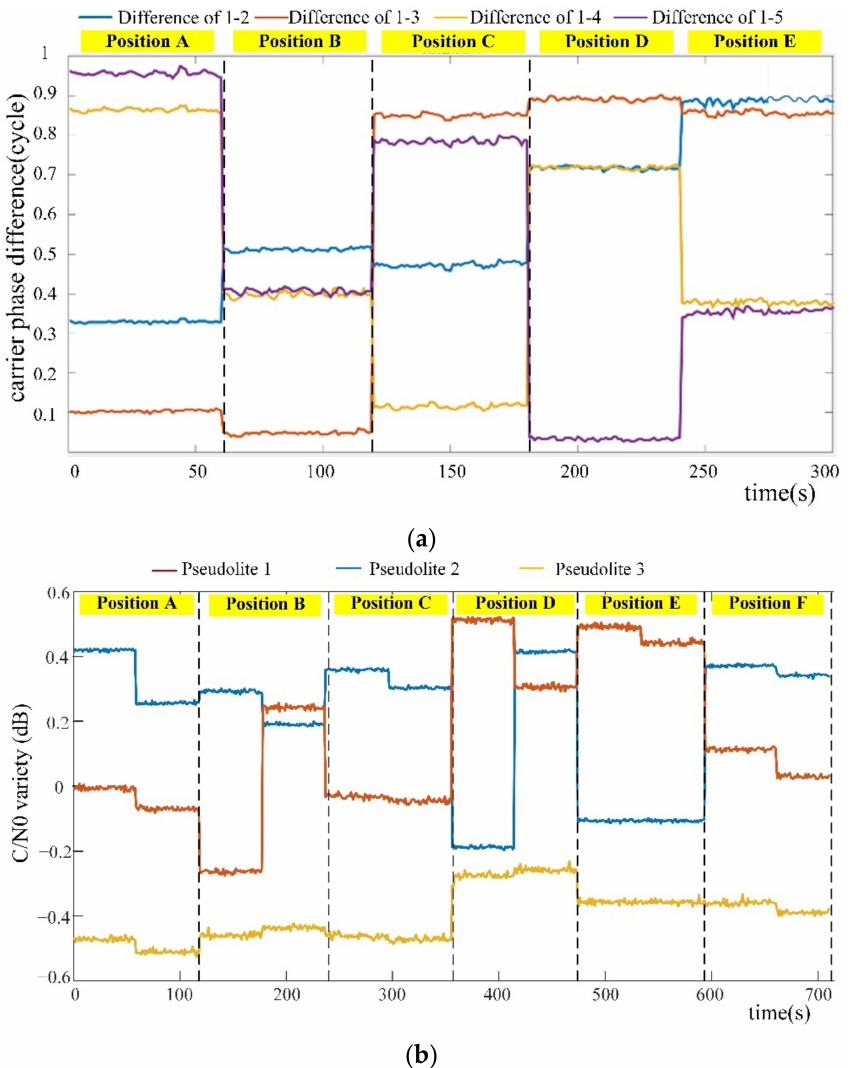
Figure 1. Location specificity and stability of carrier phase difference and C / N 0 . ( a ) Location specificity and stability of carrier phase difference. ( b ) Location specificity and stability of C / N 0 .